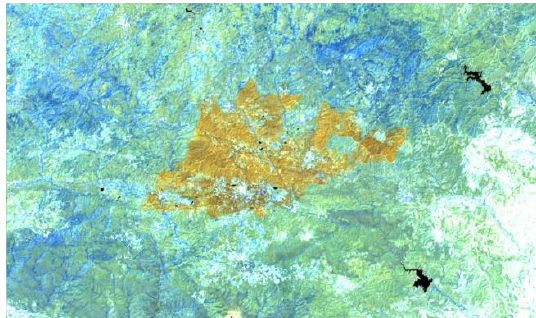
Figure 3 Sentinel-2 pseudo-color imagery (B12, B11 and B8) after the fire event 27/7/2021.